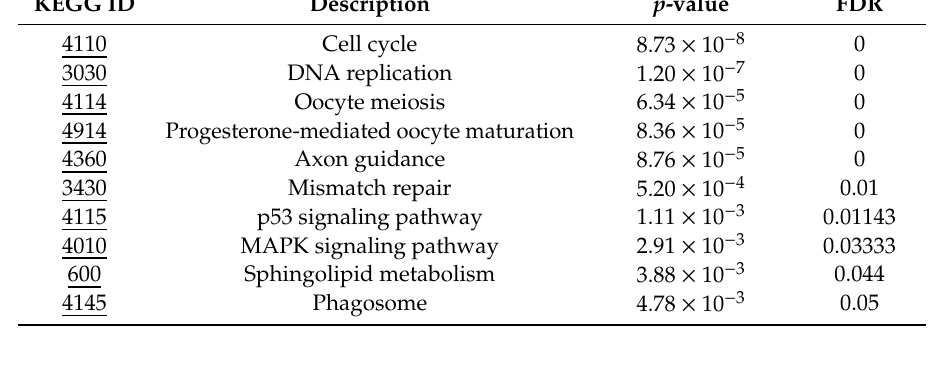
Table 2. Top enriched KEGG terms between MCF7 / pS and MCF7 / pR ranked by p -value. (pval ≤ 0.05; qval ≤ 0.05; | log 2 FC | ≥ 1).